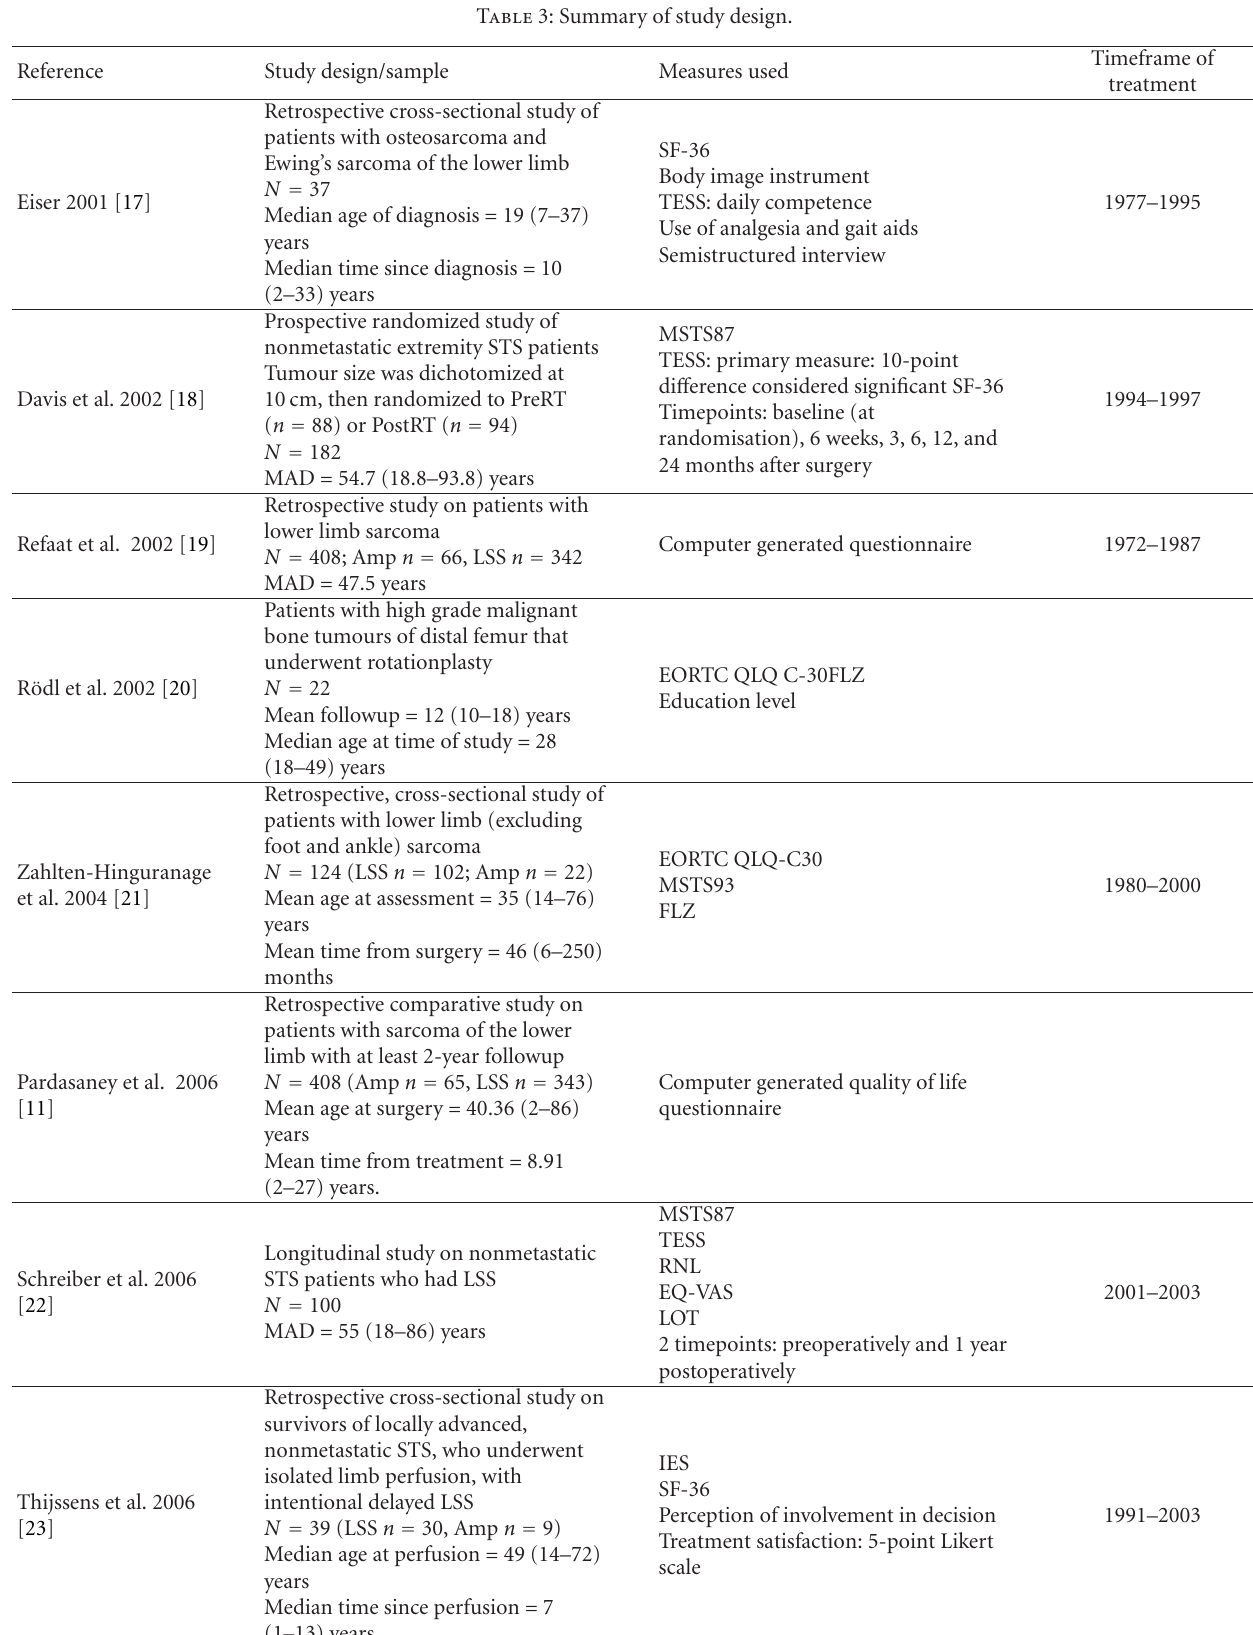
Table 3: Summary of study